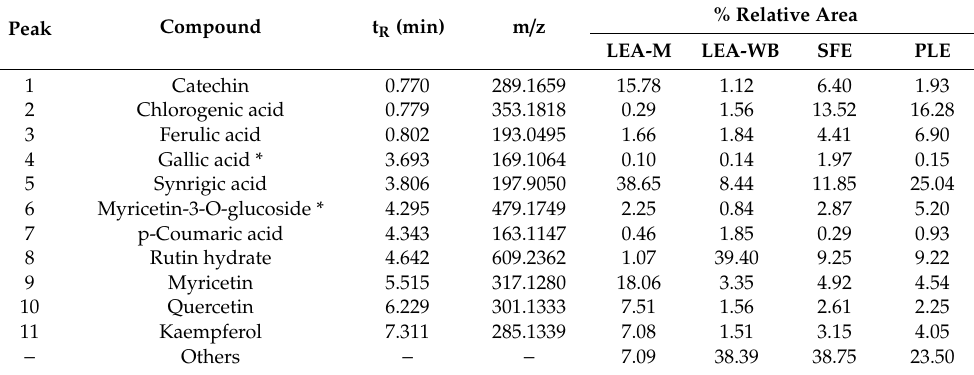
Table 2. Qualitative analysis of the extracts obtained by di ff erent